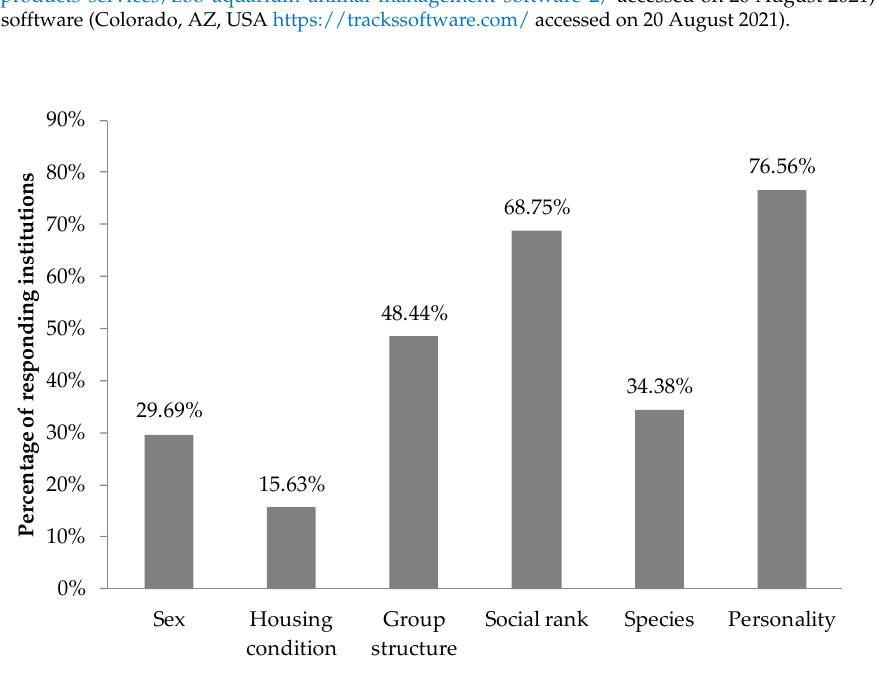
Figure 1. Variables reported by North American institutions ( n = 64) that lead to differences in training success in strepsirrhine primates.